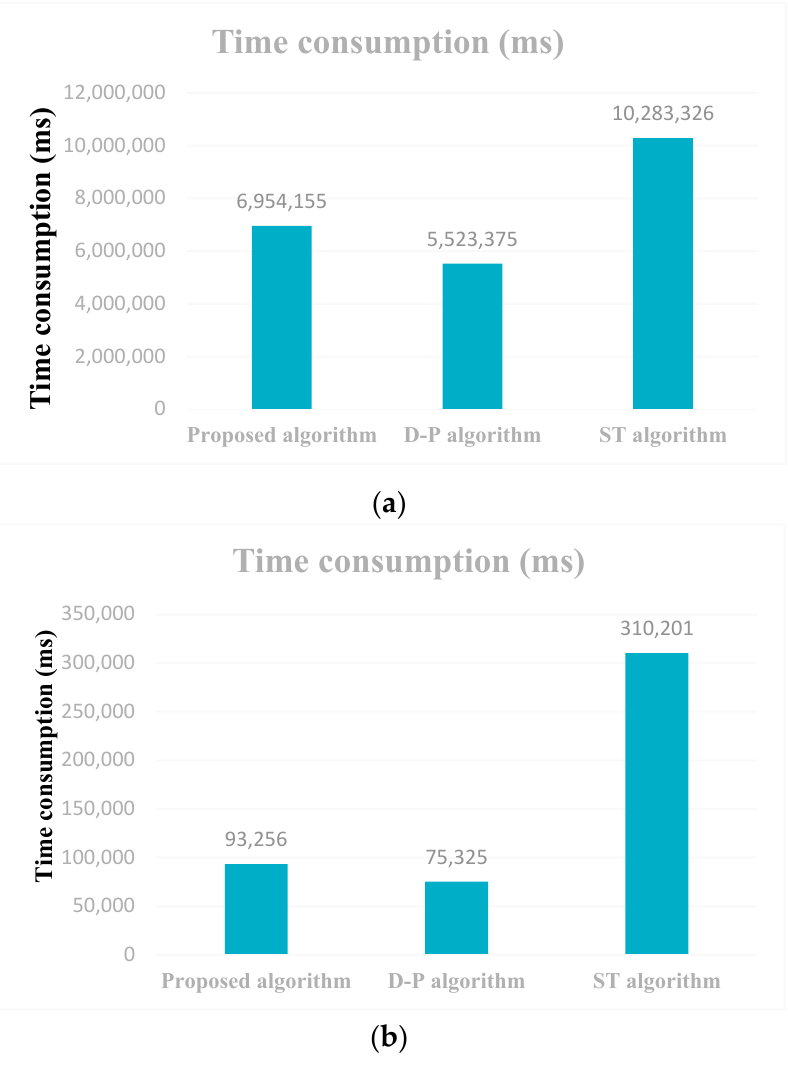
Figure 5. Time-consumption results. ( a ) Time consumption of the first group of data; ( b ) time consumption of the second group of data.